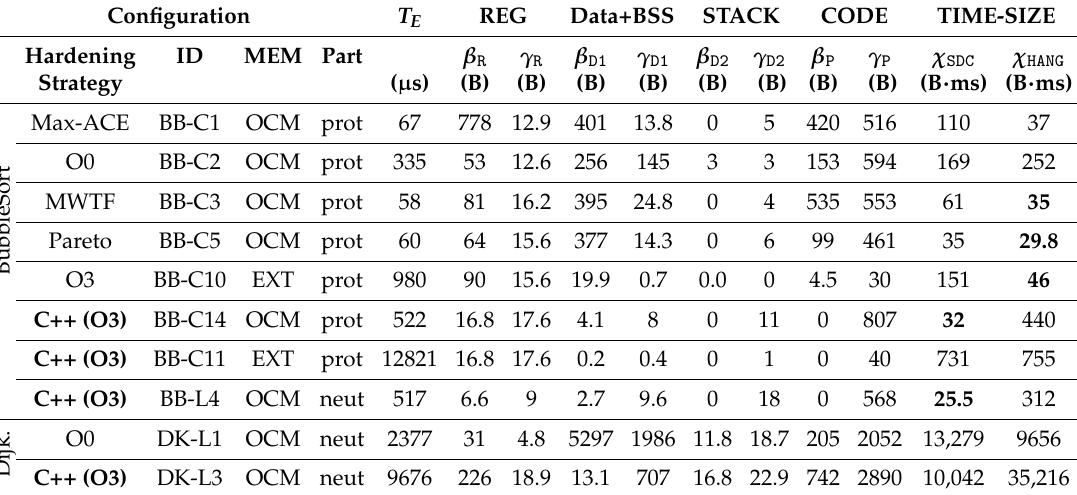
Table 6. Execution time, T E ,(for 666MHz clock) plus equivalent block sizes for SDCs and HANGs and total time-size figures for a BubbleSort and a Dijkstra program, for different compilation flags, use of C++ classes vs. other hardening techniques, for four storage blocks (registers, data memory, stack, and code memory, taken as examples, for an ARM Cortex-A9 processor, using either on-chip memory (OCM) and external rad-hard memory (EXT). Highlighted values are those referenced in the text for the sake of